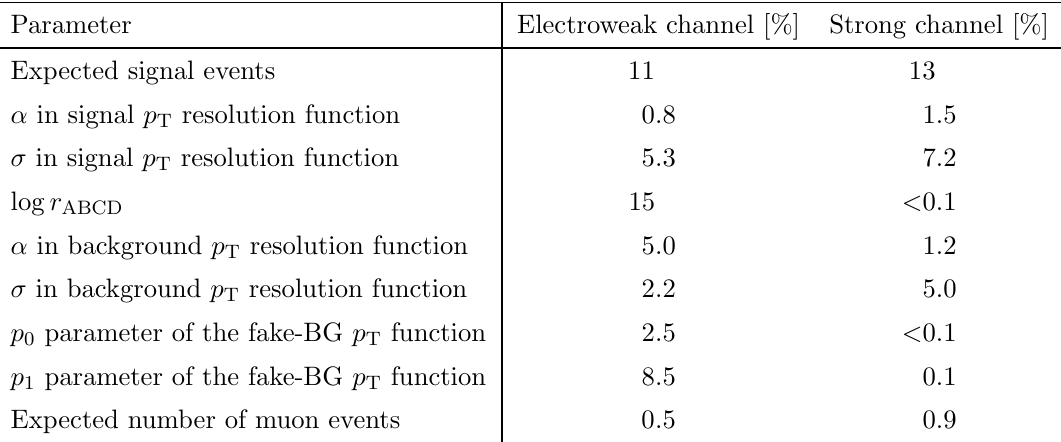
= 400 GeV ~ (cid:31) (cid:6) 1 = 500 GeV for the strong channel. The ~ (cid:31) (cid:6) 1